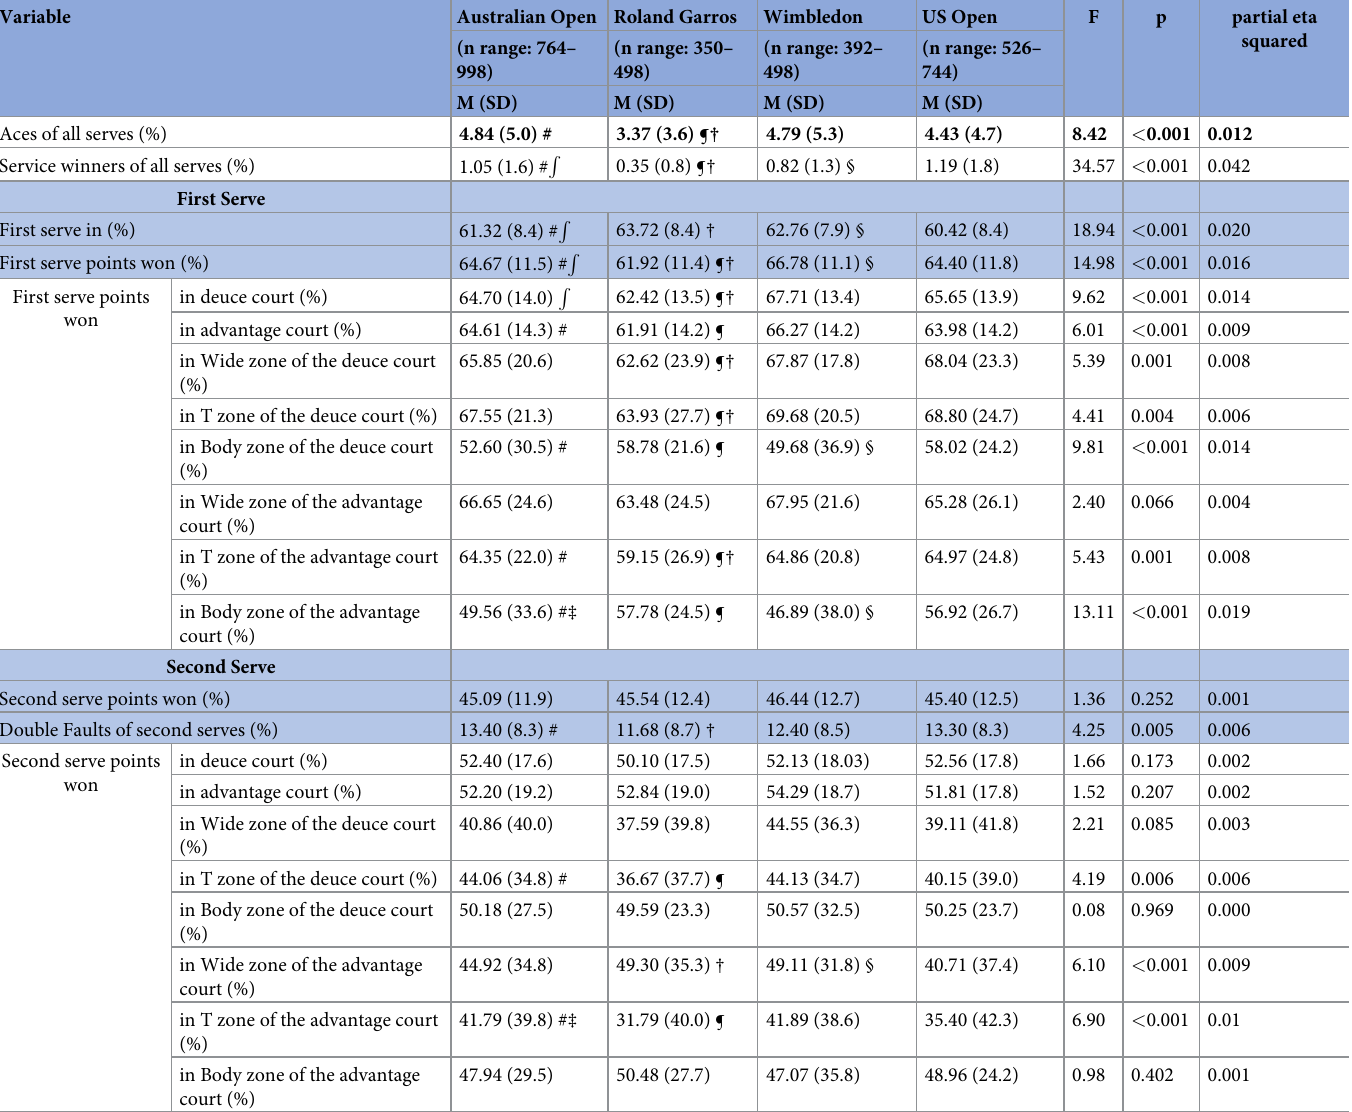
Table 1. Serve performance of female players in four Grand